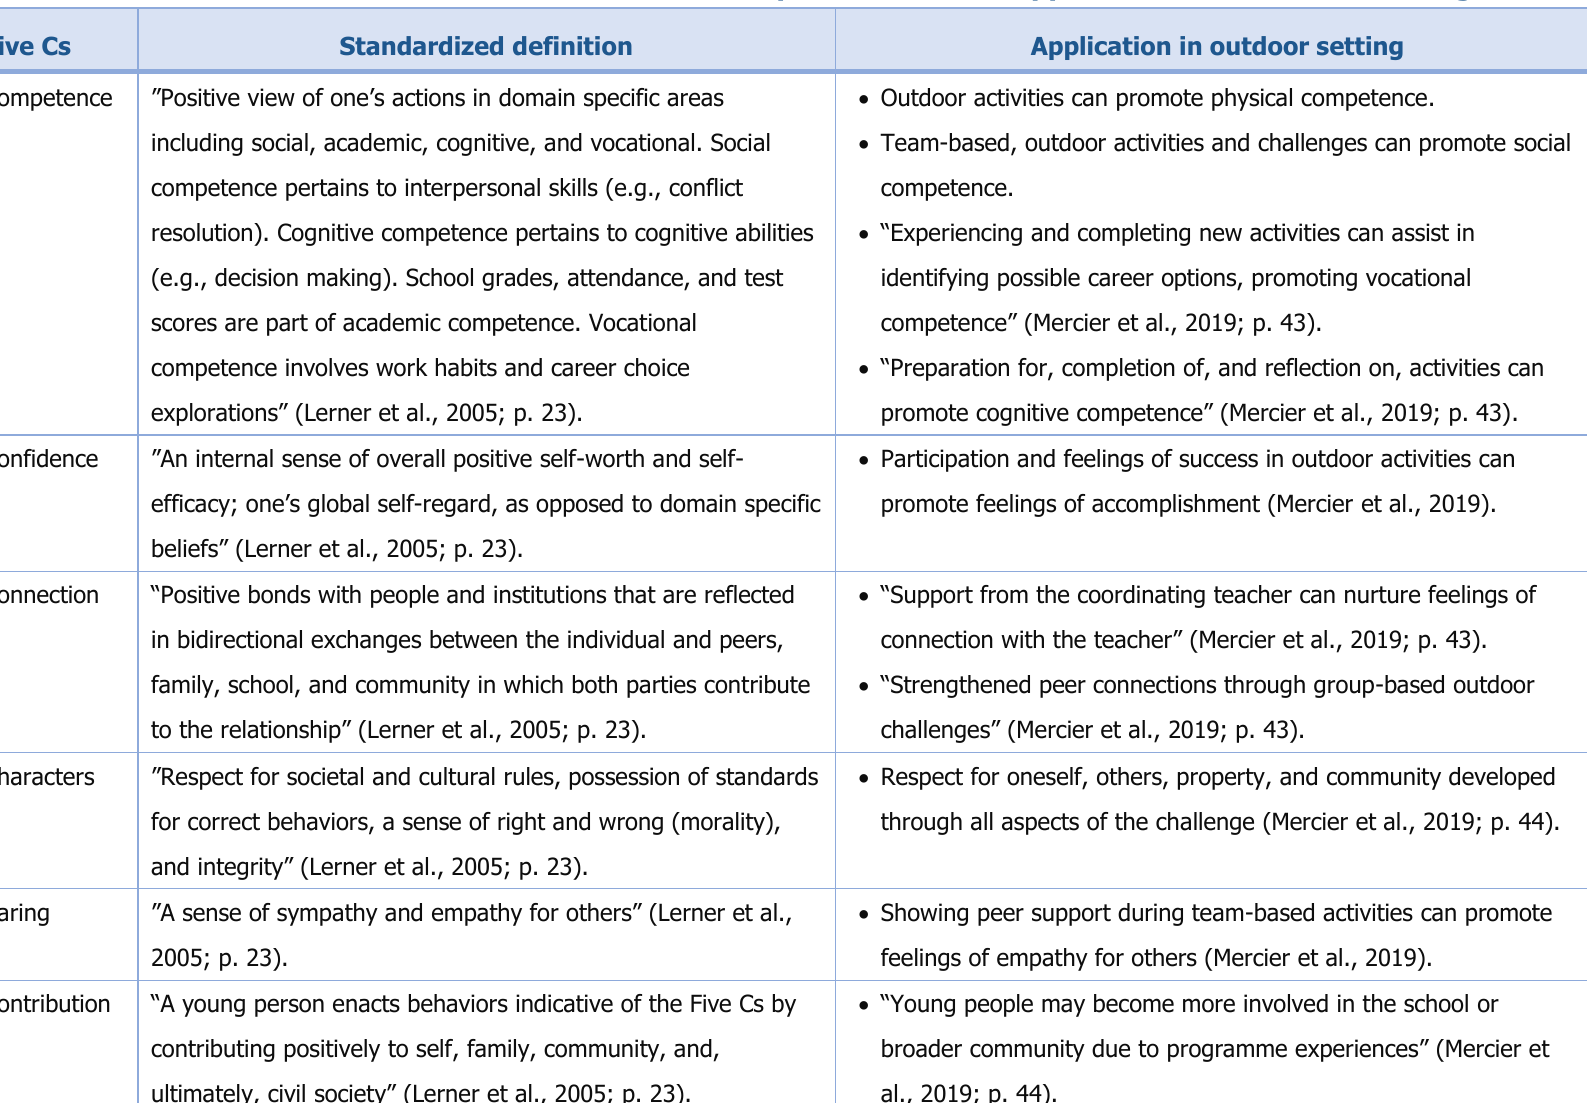
Table 1. Definitions of the Five Cs of Positive Youth Development and Their Application in an Outdoor